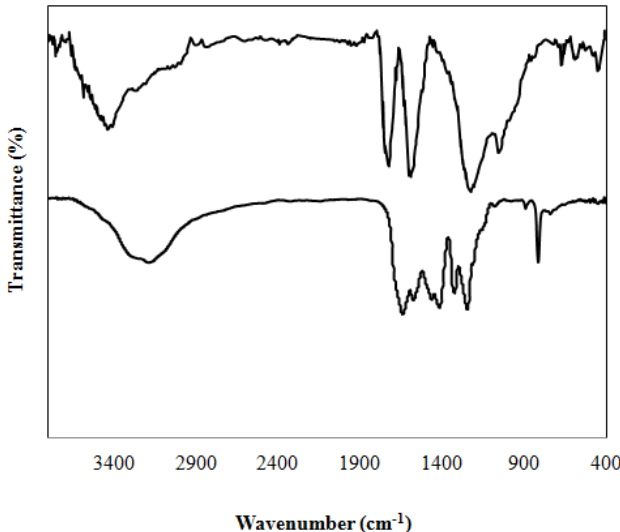
Fig. 2. FTIR spectra of the prepared graphene oxide (a), and g-C